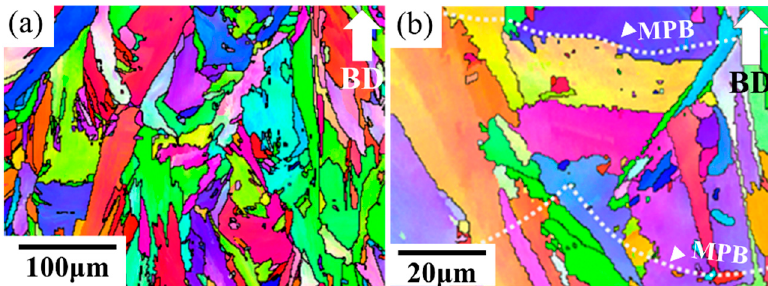
Figure 3. Inverse pole figure (IPF) maps of the as-built specimen were taken at ( a ) low magnification and ( b ) high magnification. The build direction with respect to the plane of the images is shown with an arrow.